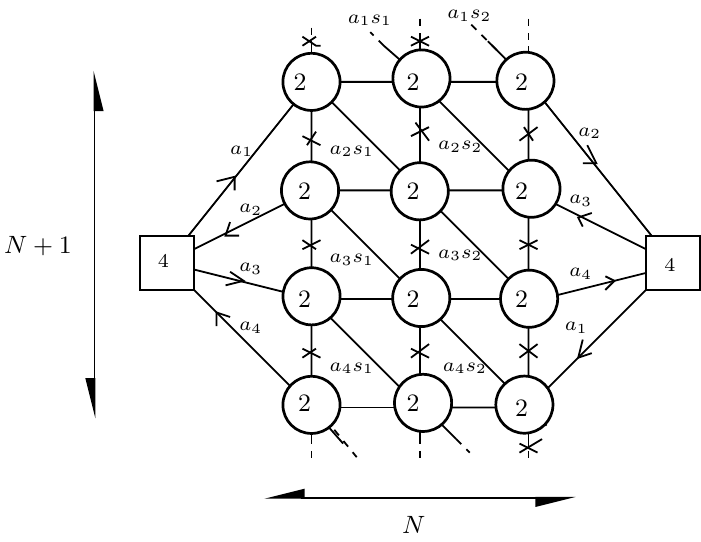
Figure 12. Torus with a unit of (cid:13)ux. The example here is for N being three. All the (cid:12)elds are charged under U(1) t symmetry. The (cid:13)ipped (cid:12)elds have charge one. The un-(cid:13)ipped (cid:12)elds get charge minus a half, and the (cid:13)ipping (cid:12)elds charge minus two. The two SU(4) together with N 1 SO(2) s symmetries build SO(2 N + 10). We have Q N +1 i (cid:0) us SU( N + 1). The symmetry which has the (cid:13)ux is U(1) t . The six dimensional R symmetry of the (cid:13)ip (cid:12)elds is two, of the (cid:13)ipped (cid:12)elds is zero, and of all other (cid:12)elds is